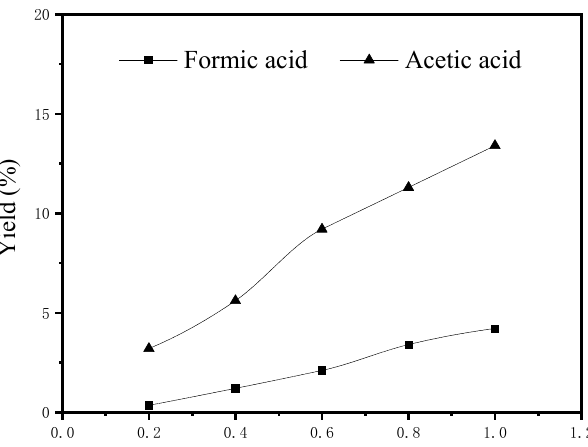
Figure 6. Effects of additional amount of NaOH (guaiacol: 2.65 mmol; 250 °C; 6 h).